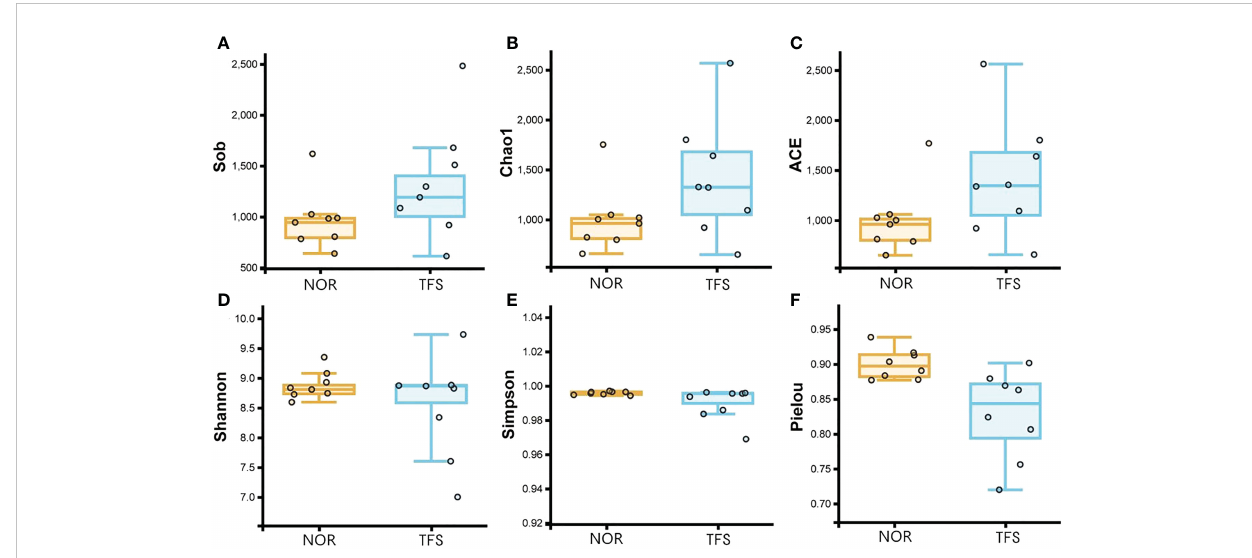
FIGURE 5 Comparisons of intestinal microbiota alpha diversity between normal (NOR) and TFS D. hystrix . Sob (A) , Chao1 (B) , ACE (C) , Shannon (D) , and Simpson (E) and Pielou indexes (F)